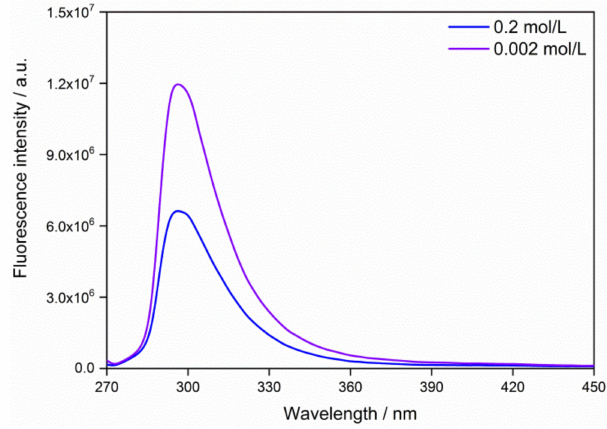
Figure 6. Fluorescence spectra of the QD0 sample with concentration of 0.2 and 0.002 mol/L.